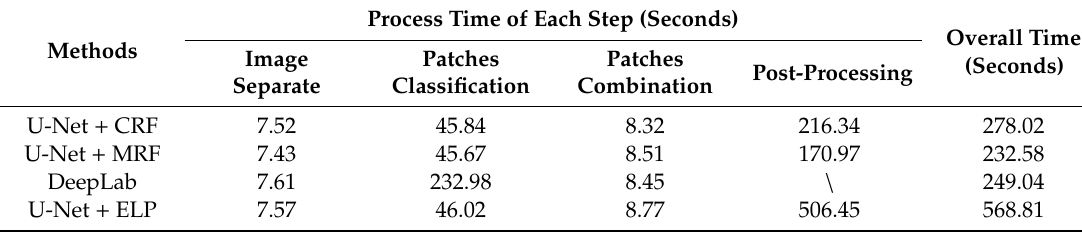
Table 7. Process time of four Table 6. Classification accuracies of the four methods.